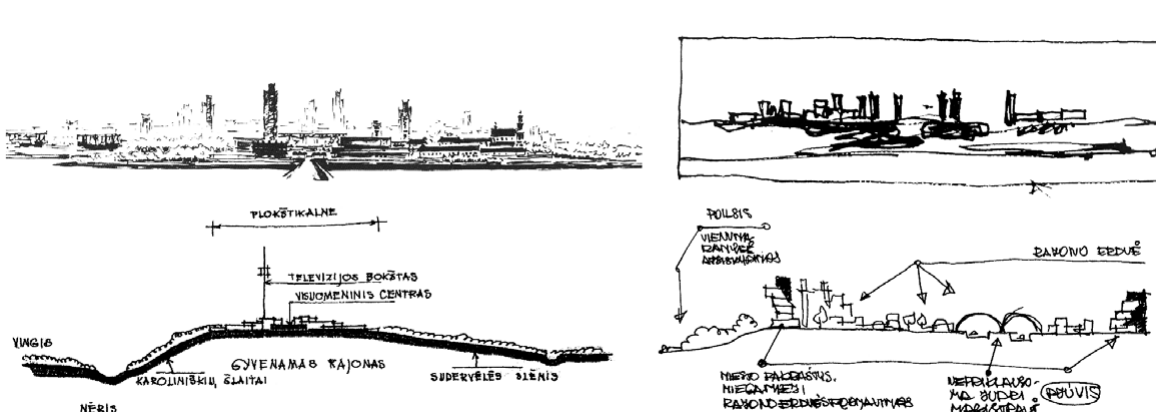
Fig. 4. Ideas of Vilnius architectural hills. above: the right bank of the neris (archit. algimantas nasvytis, 1976), lazdynai (archit. Vytautas Edmundas Čekanauskas and Vytautas Brėdikis, 1967). Below: Karoliniškės (archit. Kazimieras Balėnas, 1970), ‘city gate“ idea in the surroundings of ukmergė street (archit. raimundas arnas Dineika, Danas ruseckas, et al. ,